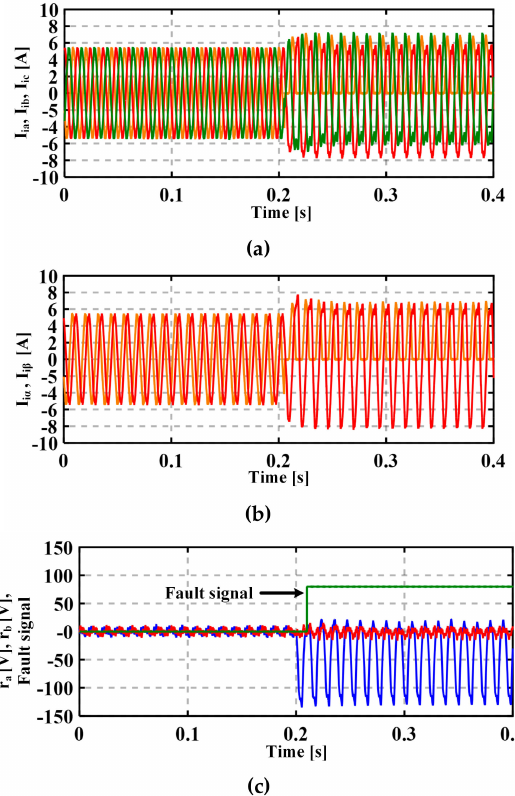
Figure 9. Experimental results: open-switch fault on Q 2 at 0.2 s. ( a ) Filter currents of the three phases I ia (yellow), I ib (red), I ic (green); ( b ) filter currents in the stationary reference frame i i α (yellow), i i β (red); ( c ) residual errors r α (blue), r β (red), and fault signal